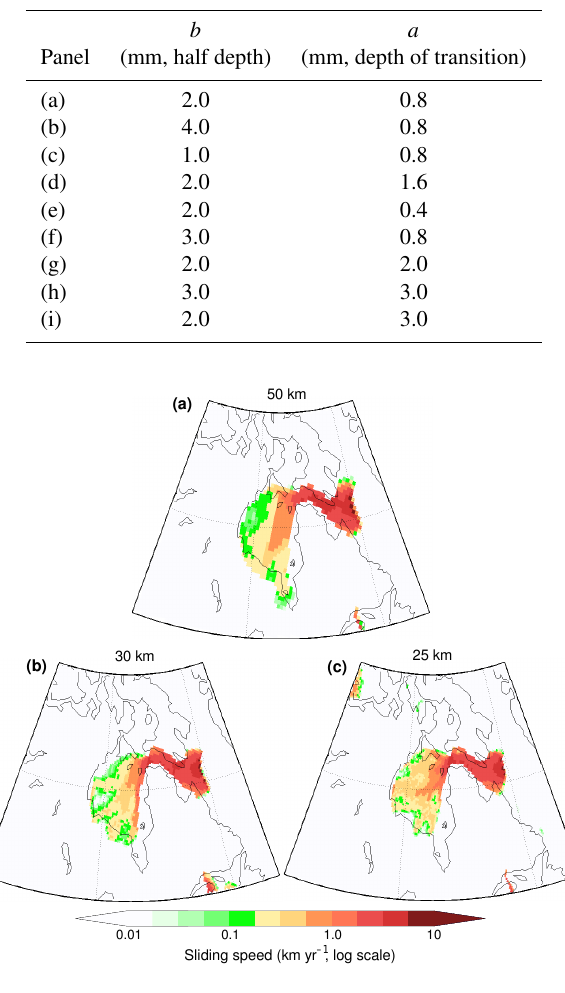
Figure 11. Instantaneous basal sliding speed for model runs at three different resolutions: (a) 50km, (b) 30km and (c) 25km. Colours for speed are plotted on a logarithmic